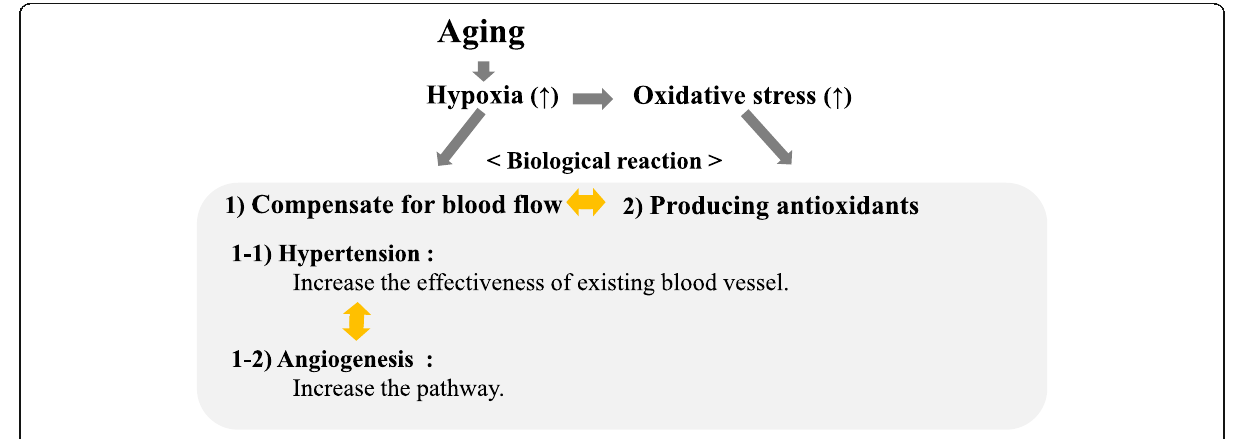
Fig. 3 Potential biological reaction to oxidative stress. Aging increases hypoxia and oxidative stress. To adjust for hypoxia, stimulating a compensation for blood flow (hypertension and angiogenesis) and producing antioxidants are programmed in living